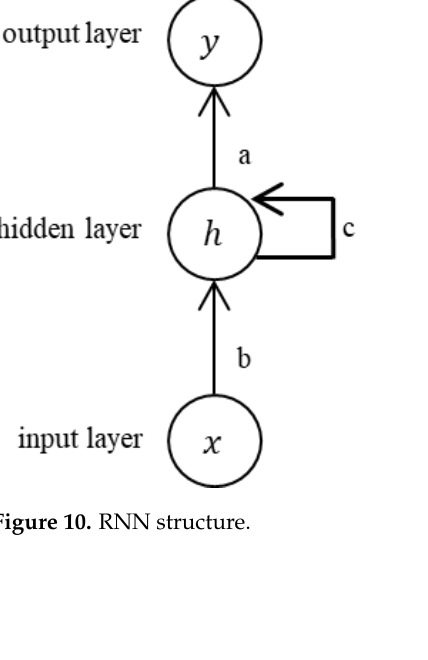
Figure 10. RNN structure.